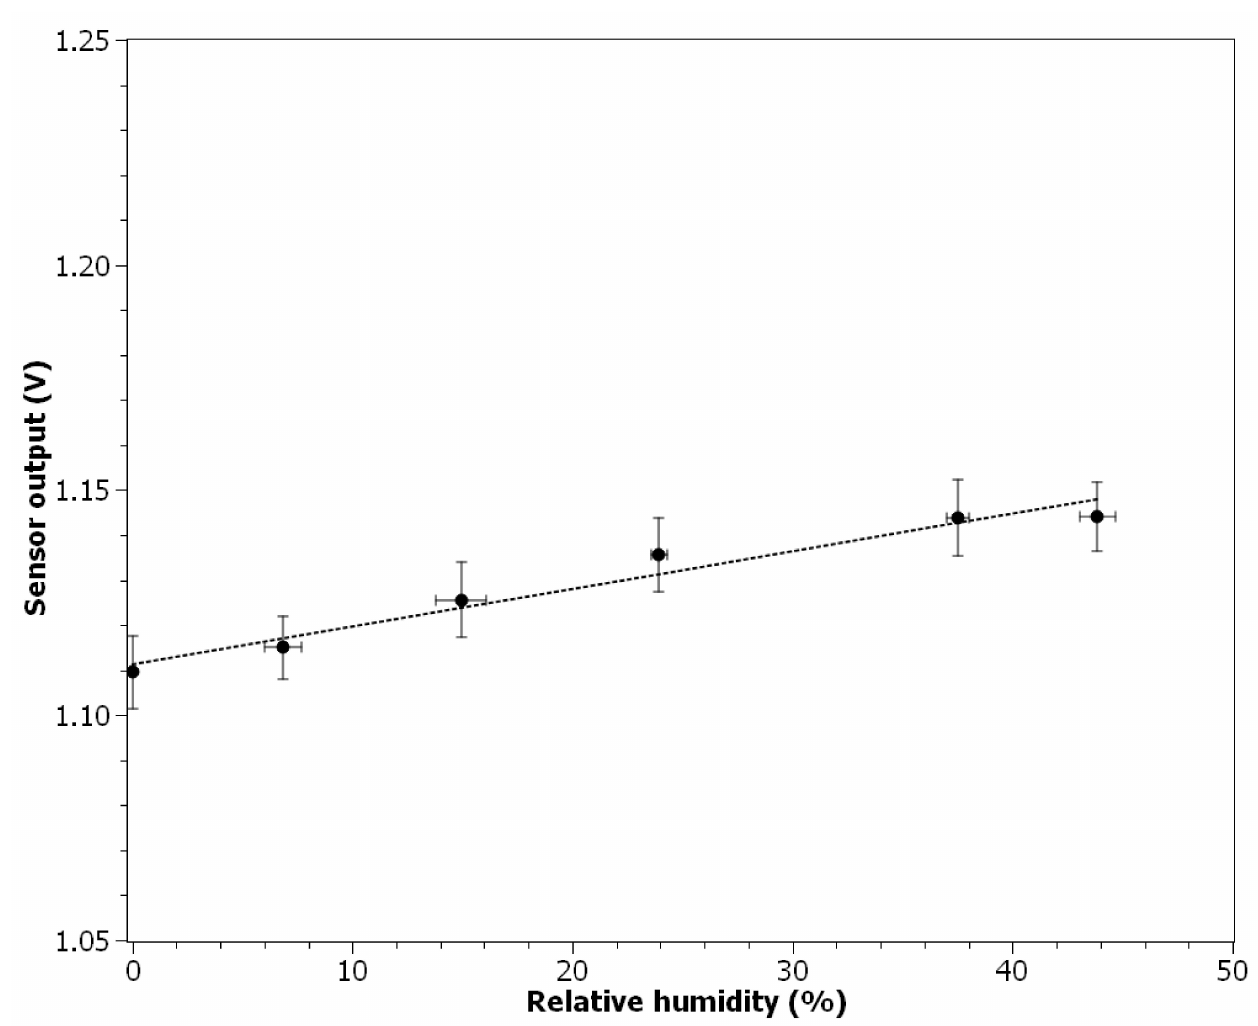
Figure 7. Relation between ionization sensor output and relative air